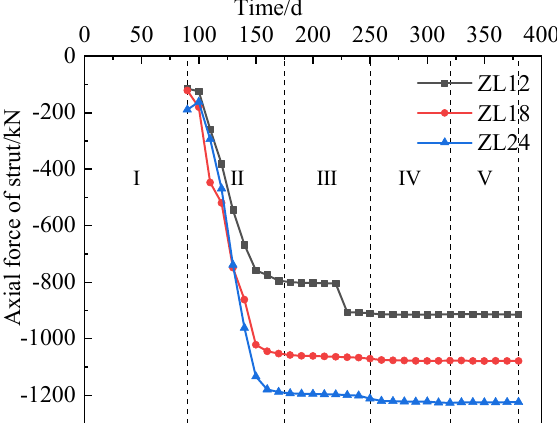
Figure 11. Road settlement curve.